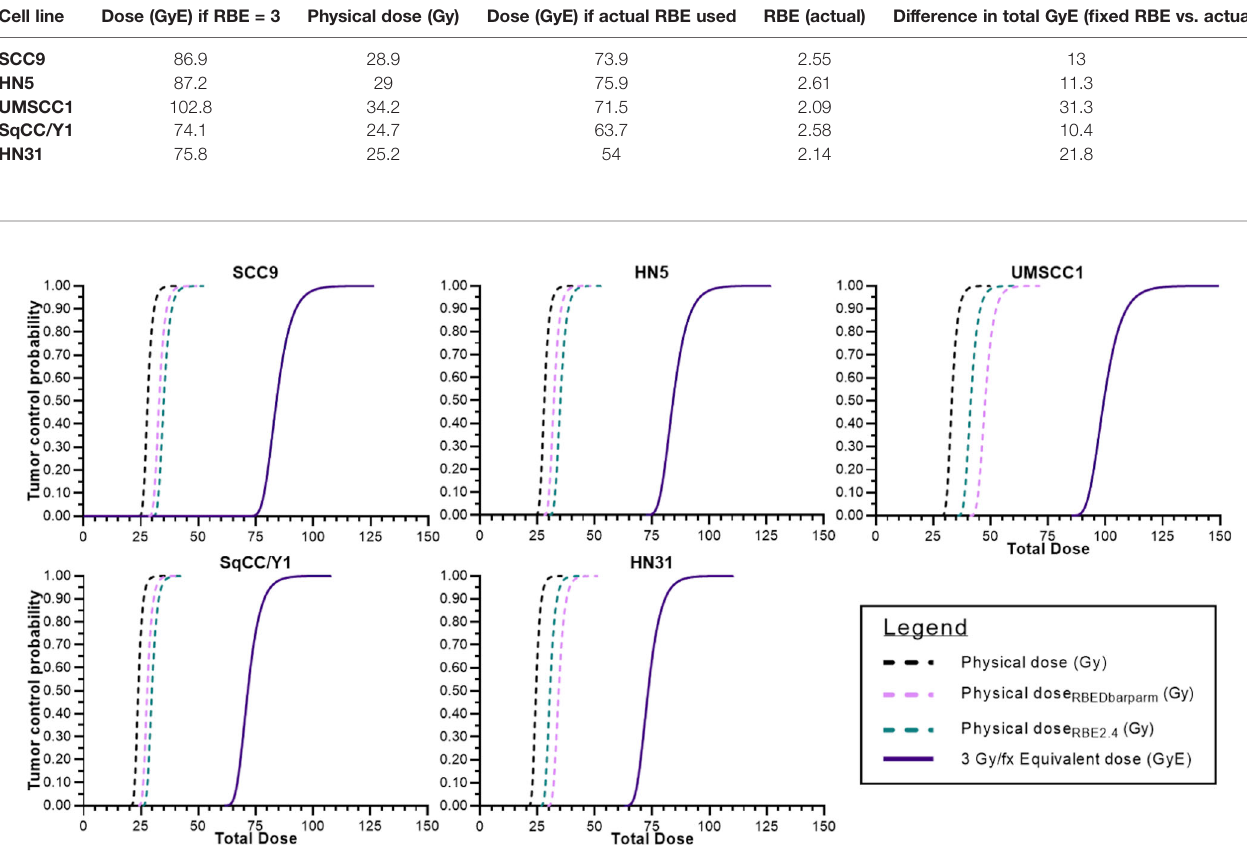
FIGURE 6 | Tumor control probabilities for each cell line after 12 C ion radiotherapy: left line is physical dose; far right line represents TCP when a clinical dose equivalent (GyE) based upon a fi xed RBE is used; and the intermediate dashed line is the physical dose necessary to achieve the same TCP as the far right curve. The interval between the two physical doses is the underdosing for each tumor. That value at a TCP of 70% is seen in Table 3